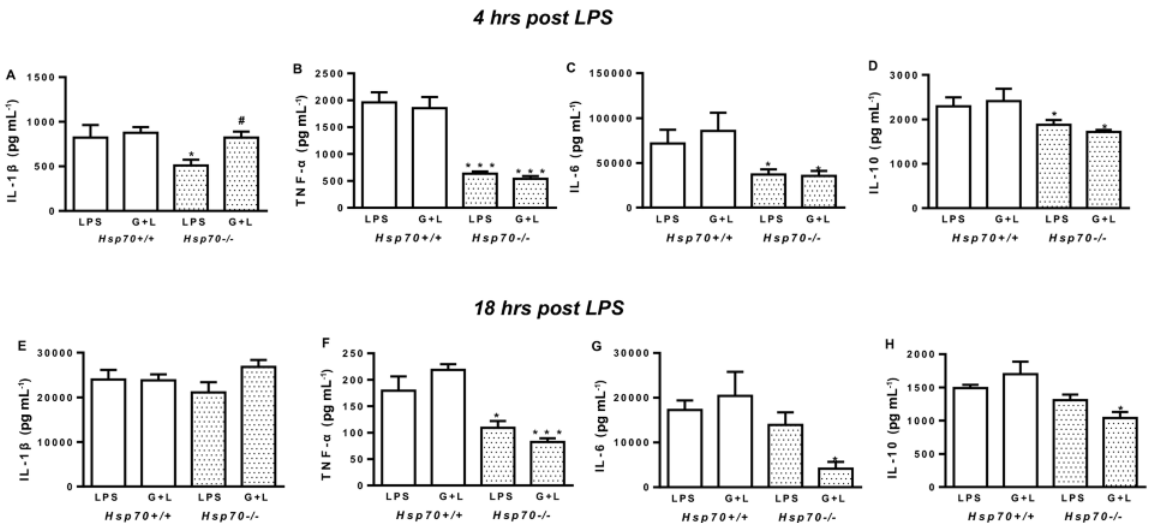
Figure 1. E ff ect of LPS and GLN on plasma cytokine secretion in Hsp70+/+ and Hsp70-/- mice. ELISA analysis of plasma cytokine levels of IL-1 β , TNF- α , IL-6 and IL-10 at 4 hrs (A-D) and at 18 hrs (E-H) post LPS administration respectively. All mice received, i.p., GLN (0.75 mg kg -1 ) or normal saline and one hour later LPS (150 μ g). Results are presented as means ± SEM. Asterisks (*) depict statistical di ff erence between genotypes exposed to the same treatment. *, p < 0.05; **, p < 0.001; ***, p < 0.0001. Hash signs (#) depict statistical di ff erence between treatments on the same genotype. #, p < 0.05. Each graph shows a representative experiment of at least three independent